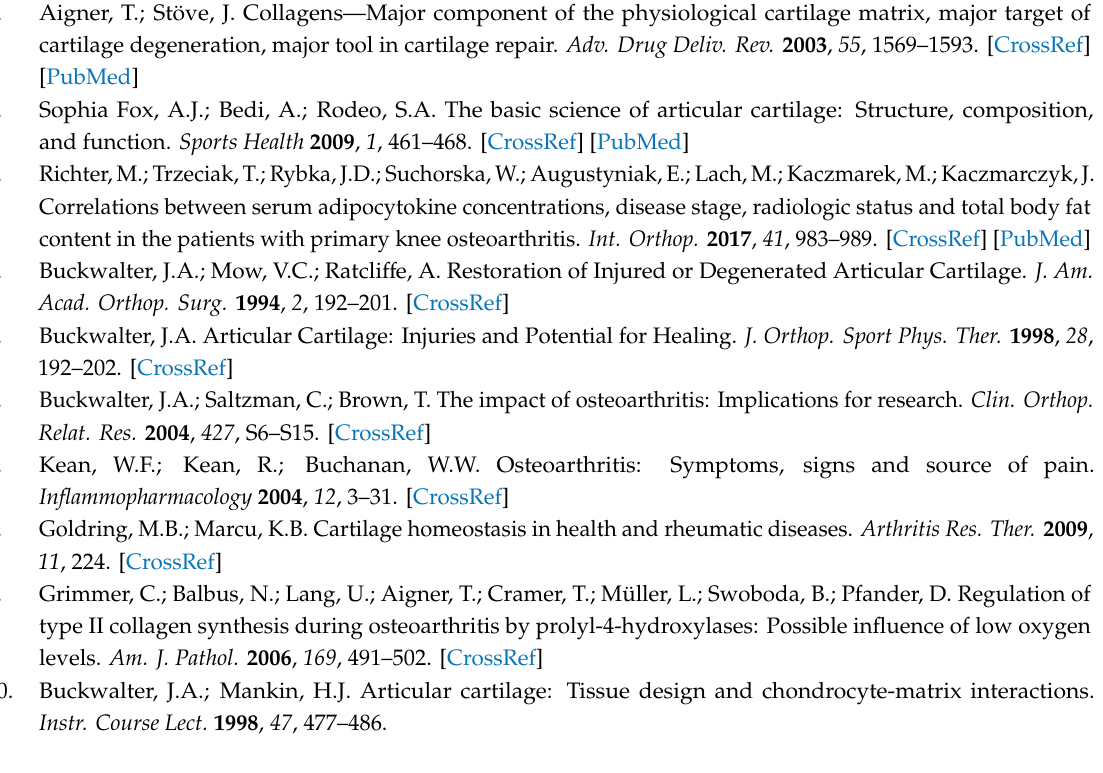
Figure S1: Exemplary raw data obtained from the measurements; Figure S2: Exemplary raw data obtained from the measurements; Figure S3: Exemplary raw data obtained from the measurements; Figure S4: Exemplary raw data obtained from the measurements; Figure S5: Exemplary raw data obtained from the measurements; Figure S6: Exemplary raw data obtained from the measurements; Figure S7: Representative histology sections of HWB cartilage (Safranin-O / Fast Green staining); Figure S8: Relative frequency of mean elastic modulus of: (a) low weight bearing (LWB) sample and (b) high weight bearing (HWB) sample; Figure S9: Relative frequency of mean hardness of: (a) low weight bearing (LWB) sample and (b) high weight bearing (HWB) sample. Table S1: Elastic modulus and hardness of high weight bearing (HWB) and low weight bearing (LWB) articular cartilage; adjusted to patients’ sex tested within the groups, Table S2: Correlations between high weight bearing cartilage (HWB) and low weight bearing cartilage (LWB) mechanical parameters and age or OA grade tested within the